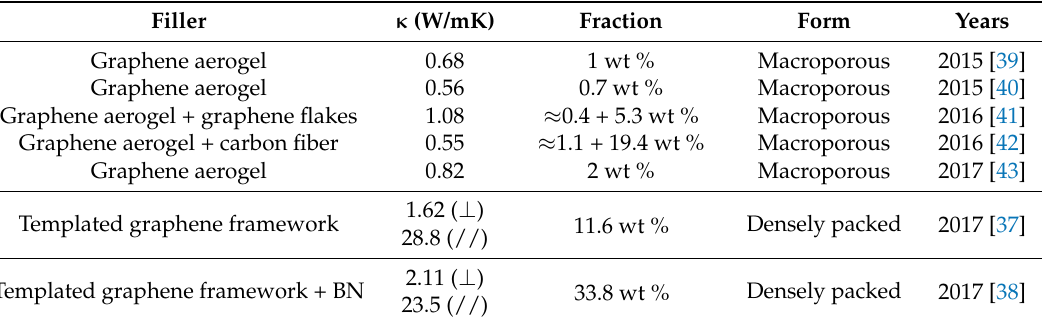
Table 3. Summary of graphene framework/polydimethylsiloxane (PDMS) composites. Filler κ (W/mK)